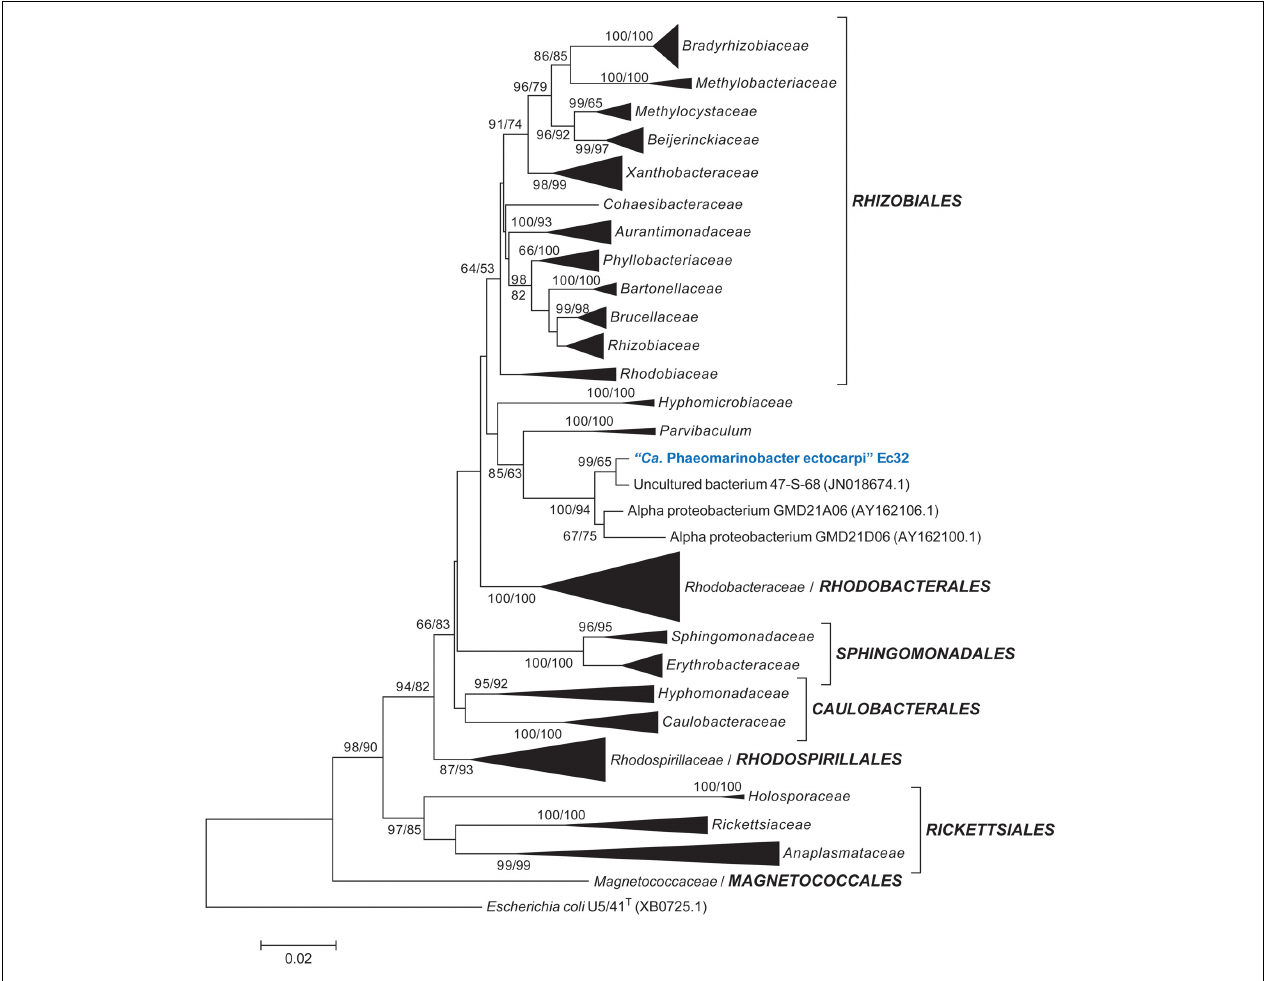
FIGURE 1 | Taxonomic position of “ Ca. Phaeomarinobacter ectocarpi” Ec32 within the Alphaproteobacteria . The figure shows a neighbor-joining tree of 236 16S rDNA sequences with bootstrap support values obtained for this and a corresponding maximum likelihood tree, respectively (only